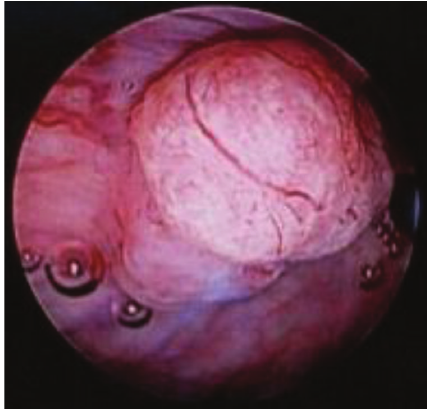
Figure 1: Nodular, broad-based tumors observed in the anterior wall of the urinary bladder.